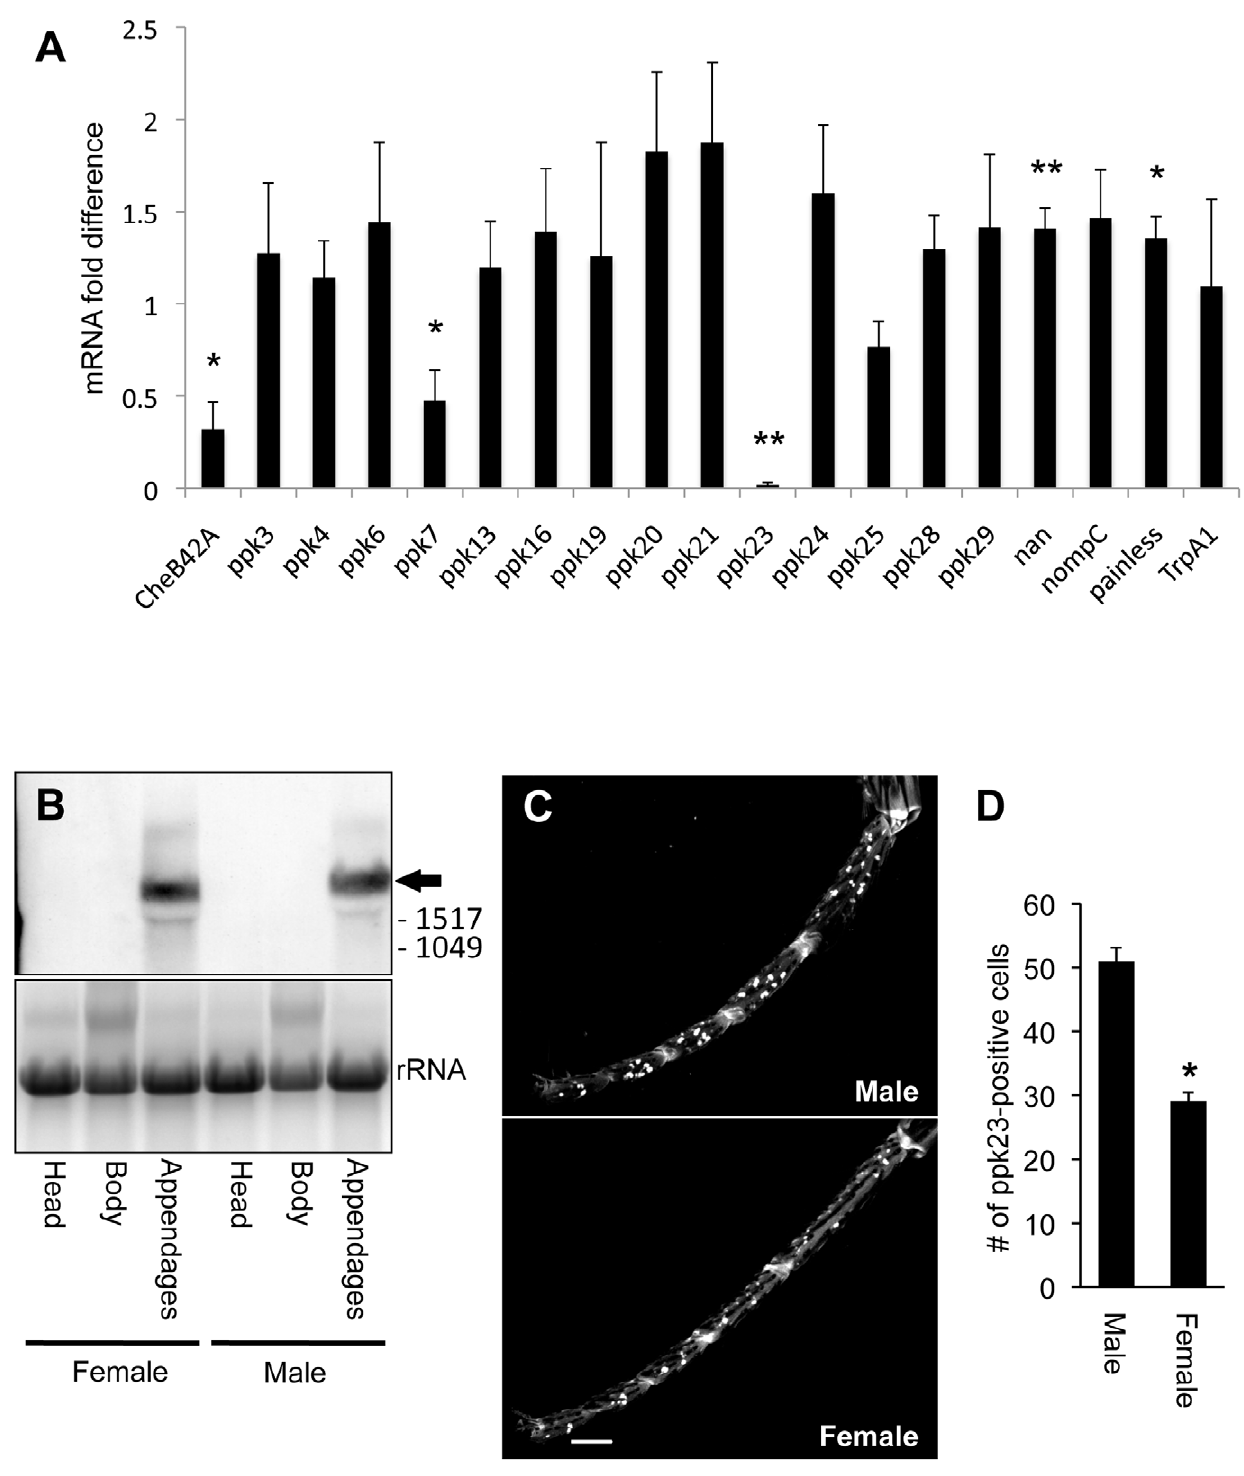
Figure 1. ppk23 expression is reduced in appendages of the Poxn mutant. (A) Real-time quantitative RT-PCR analysis of total RNA extracted from adult appendages (legs and wings) from a mixed sex population. Analysis compared Poxn M22-B5 , which do not have external chemosensory bristles, and CyO balanced siblings, which develop normal sensory bristles [54]. For illustrative purposes, data are represented as relative expression fold differences in Poxn flies relative to controls [51]. Each data point includes the relative expression of a gene in Poxn homozygous flies relative to balanced Poxn/CyO flies, which develop normal sensory system. CheB42a gene was used as positive controls for chemosensory specific genes expressed in appendages [16,17,55]. Statistical analyses were performed on the D Ct data as previously described [16,17,51]. *, p , 0.05; **, p , 0.01 (n=4 per genotype, one-tail paired t -test) (B) Northern blot analysis of ppk23 spatial expression patterns. Lower panel shows ribosomal bands on the RNA gel, indicating equal sample loading. Using RT-PCR coupled with 5 9 and 3 9 RACE analyses on RNA extracted from male appendages, we were